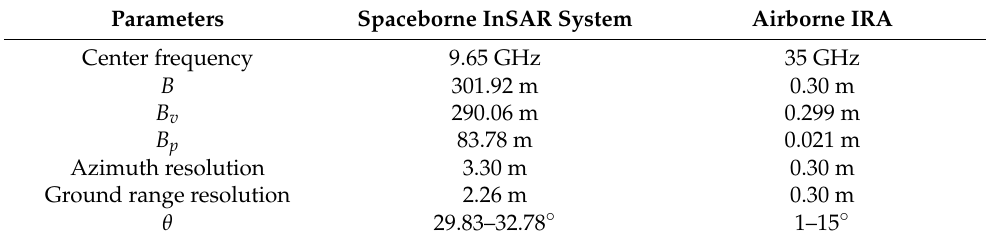
Table 1. SAR image parameters of the TerraSAR-X and TanDEM-X satellites and airborne IRA.